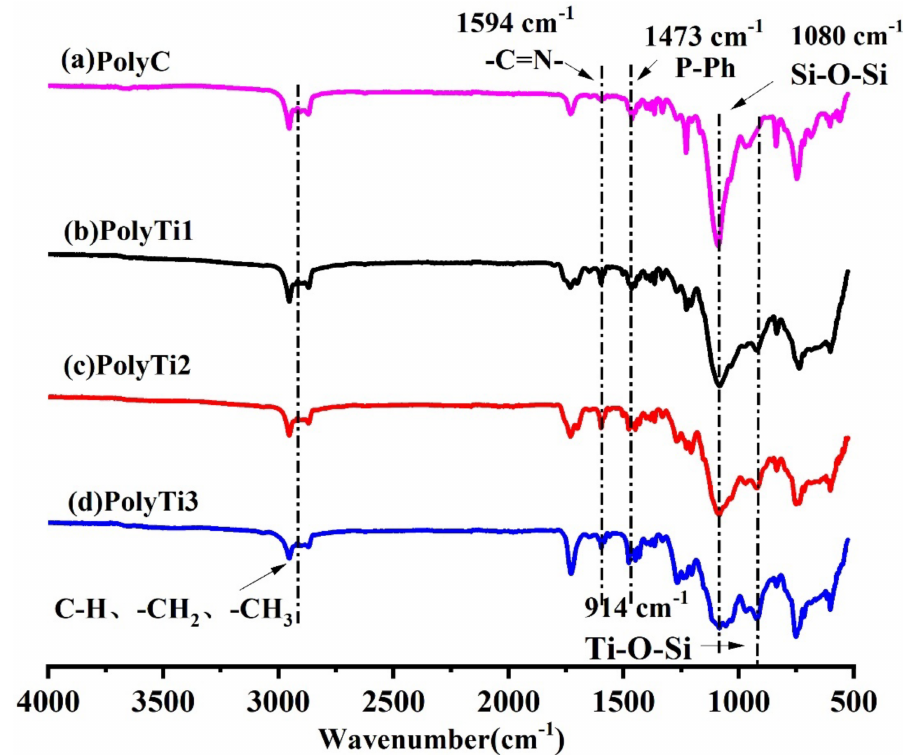
Figure 3. FTIR spectra of ( a ) PolyC, ( b ) PolyTi1, ( c ) PolyTi2 and ( d )